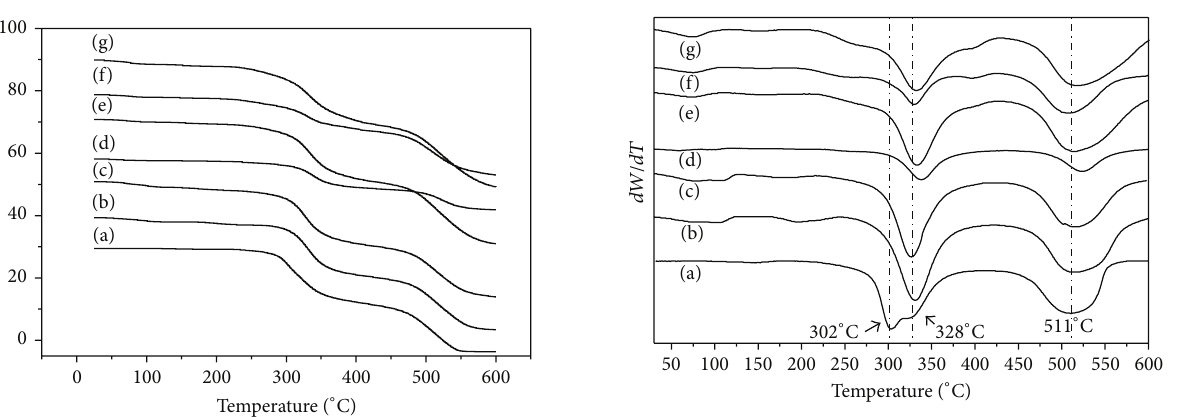
Figure 5: TGA curves of MR resin (a), MR-EDA resin (b), MR- DETA resin (c), MR-TETA resin (d), MR-EDA-TCEP resin (e), MR- DETA-TCEP resin (f), and MR-TETA-TCEP resin (g) heated with the temperature increment rate 5 ∘ C min −1 in air.